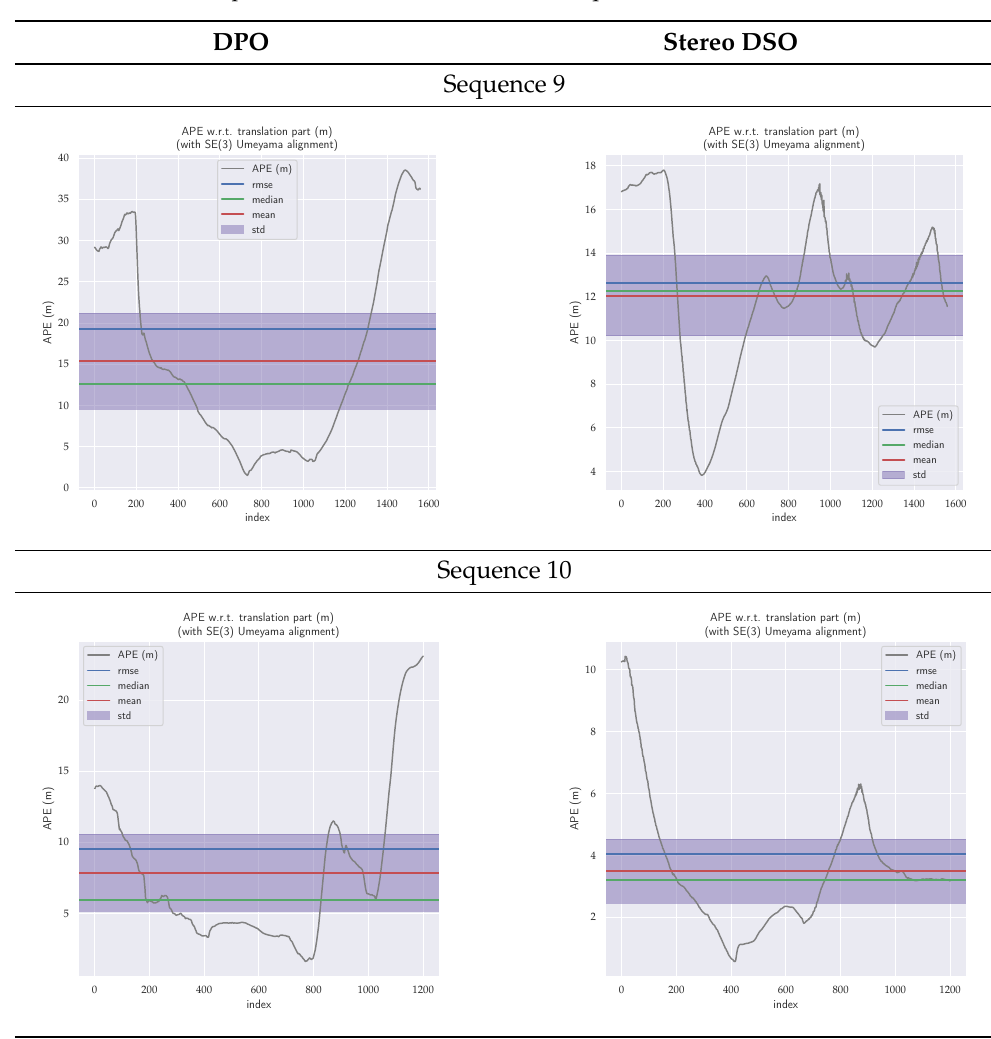
Table 3. The absolute pose error (APE) for all frames of sequences 9 and 10 of the KITTI